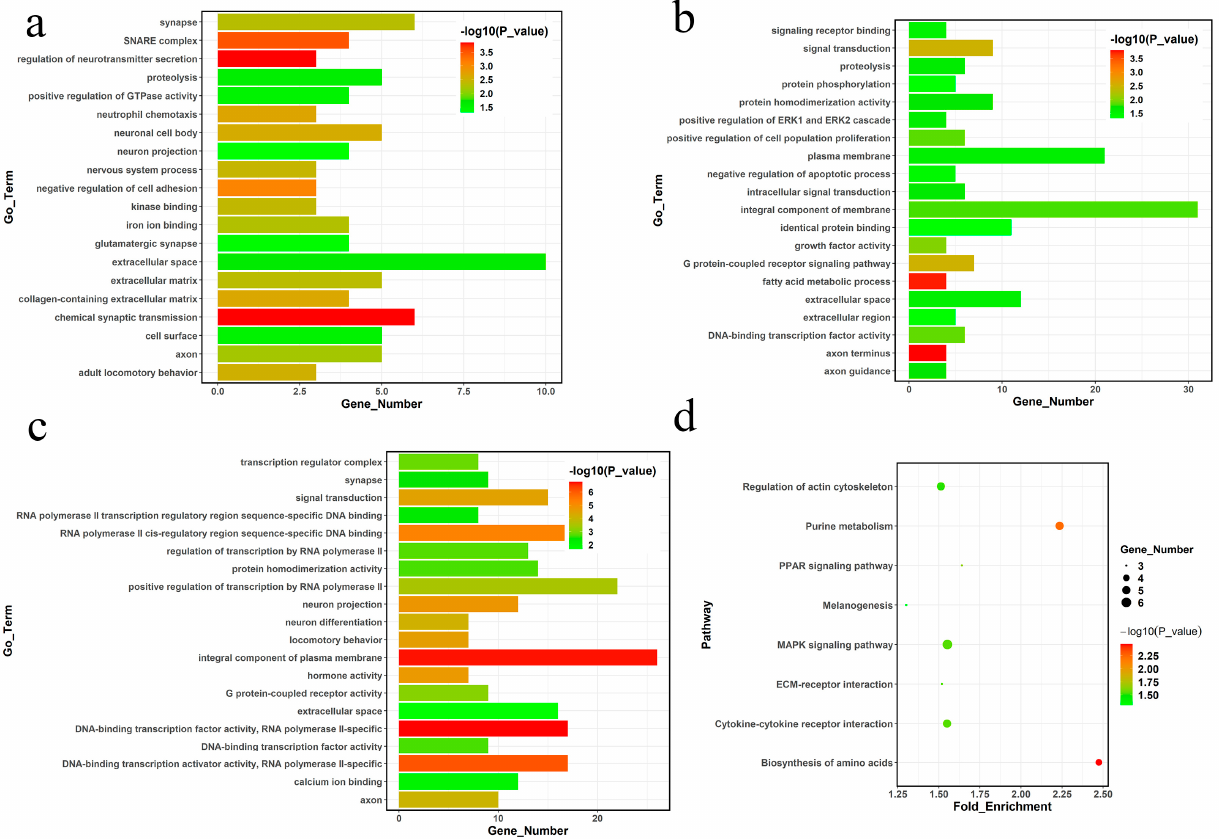
Figure 3. Functional analysis of DEGs. Significant GO terms of the ( a ) testis, ( b ) muscle, and ( c ) hypothalamus. ( d ) Top eight significant KEGG pathways of muscle.